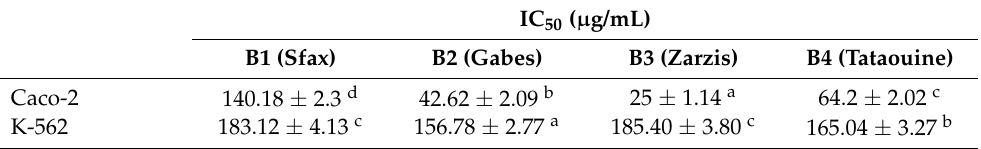
Data are the mean of three replicates ± SD. Different superscript letters above the values in the same line indicate